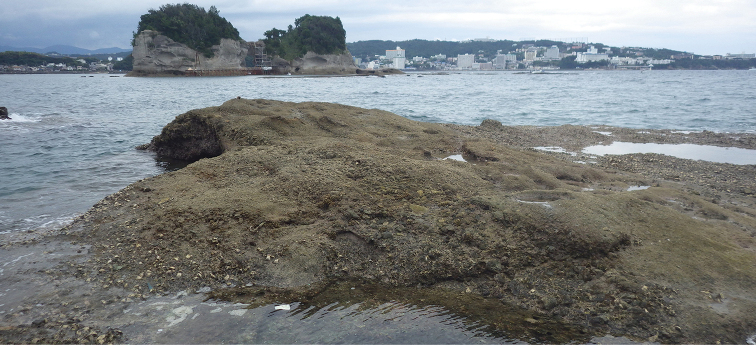
Habitat, Peronia
setoensis, Japan, Honshu, near the Seto Marine Laboratory, type locality, exposed rock wall and platform.